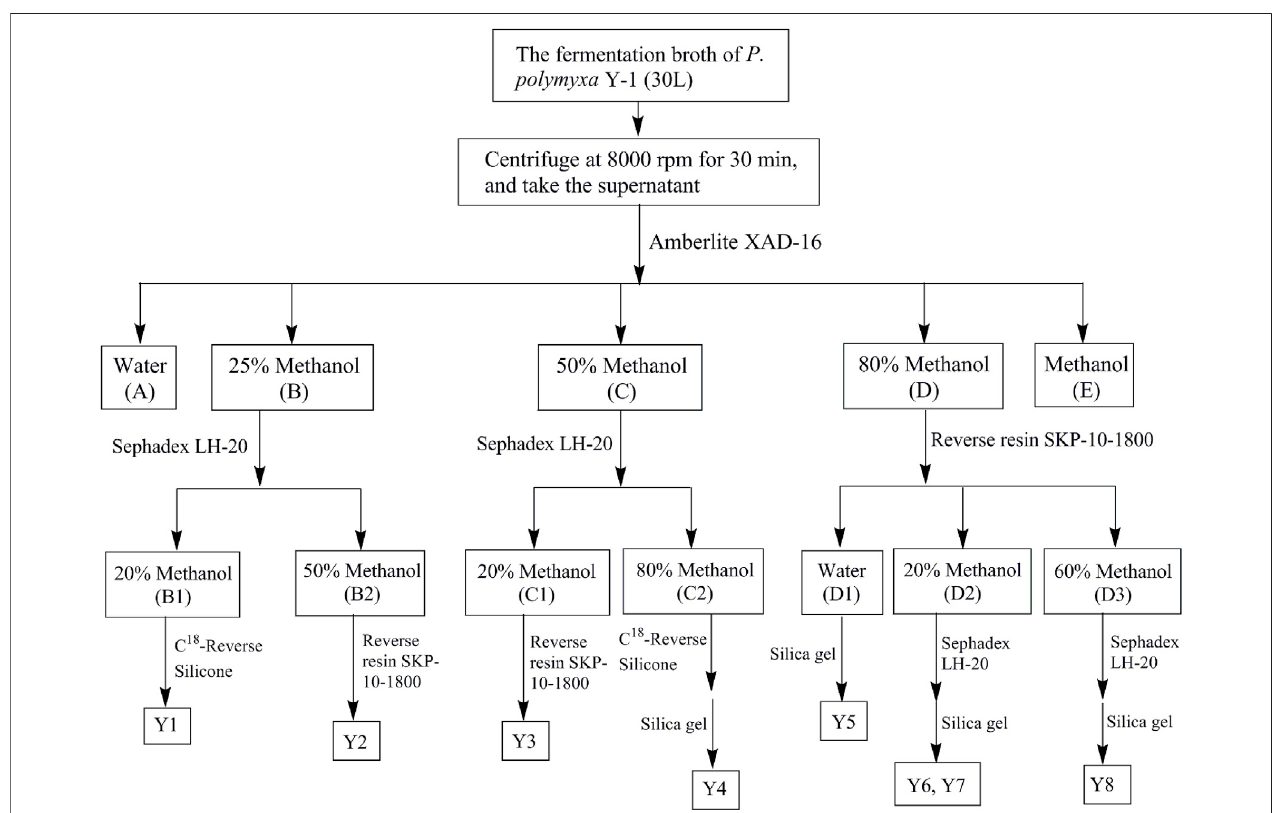
FIGURE 1 | Metabolites extraction, separation, and puri fi cation fl ow chart of P. polymyxa Y-1.